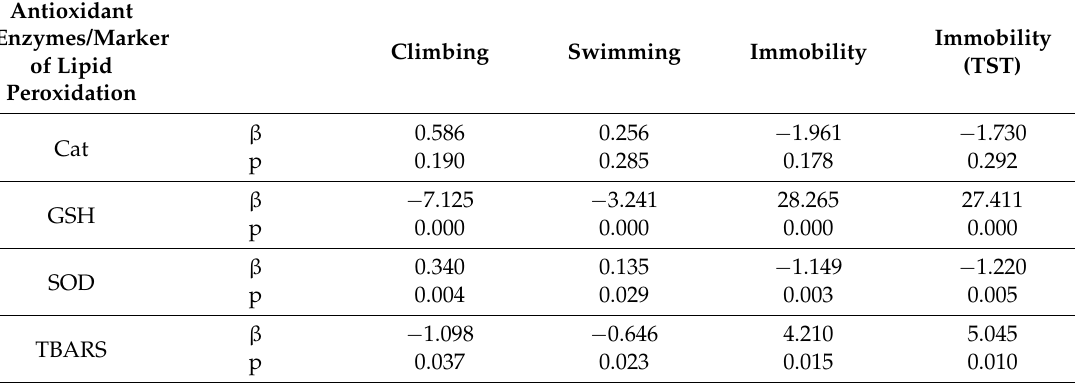
Table 1. Multiple linear regression analysis on the dependent variables of climbing,